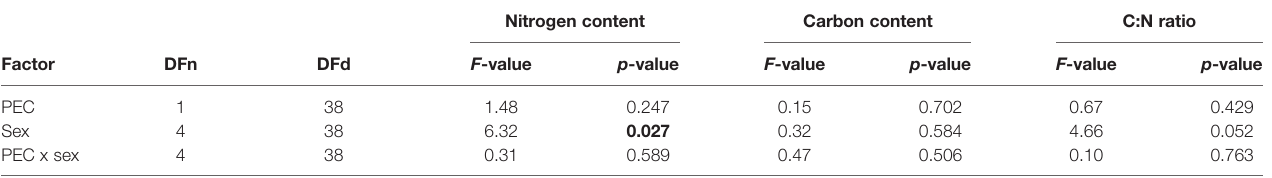
TABLE 2 | Results of two-way ANOVA to investigate the effects of pre-experimental cultivation (PEC) and sex on nitrogen content, carbon content and carbon: nitrogen (C:N) ratio of vegetative Laminaria digitata gametophytes kept in long-term cultivation at 5°C and 15°C. Nitrogen